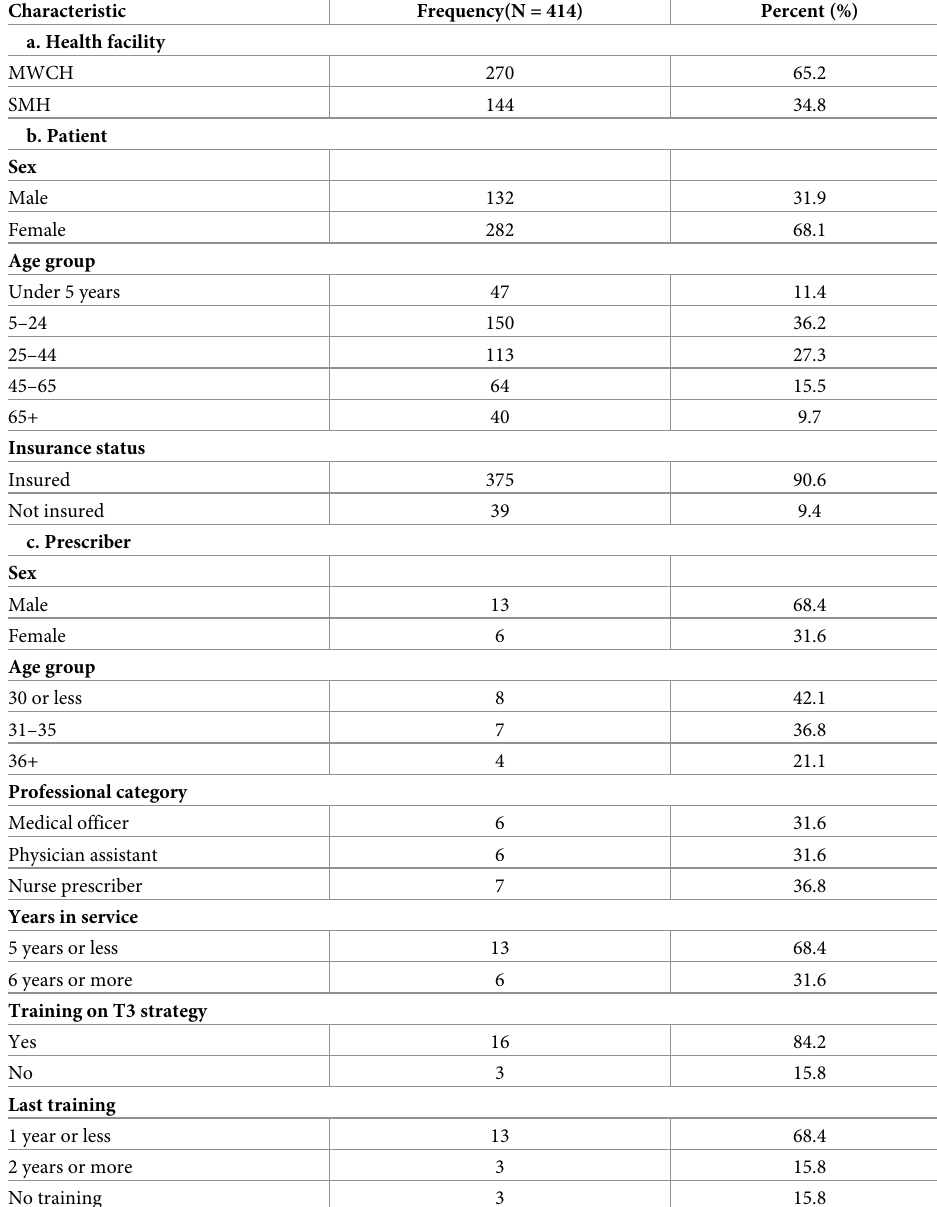
Table 1. Demographic characteristics of study